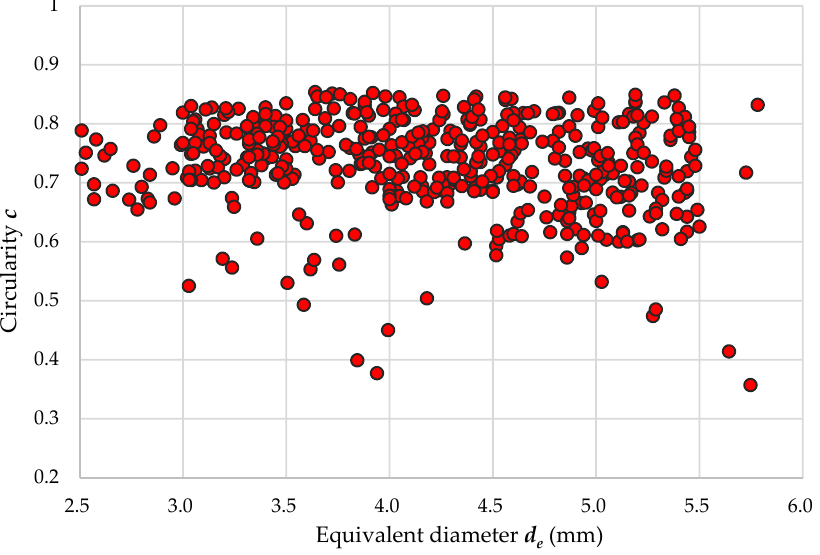
Figure 4. Relationship between circularity of shale cuttings and equivalent diameter distribution.